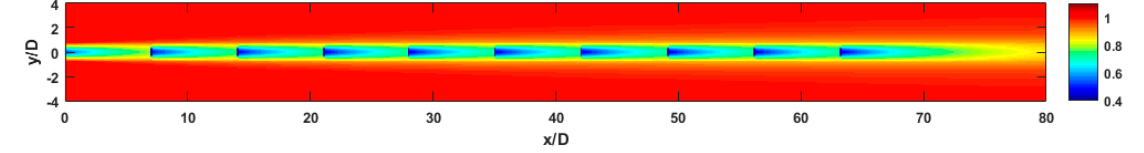
Figure 11. Contours of the wake velocity for 10 wind turbines.